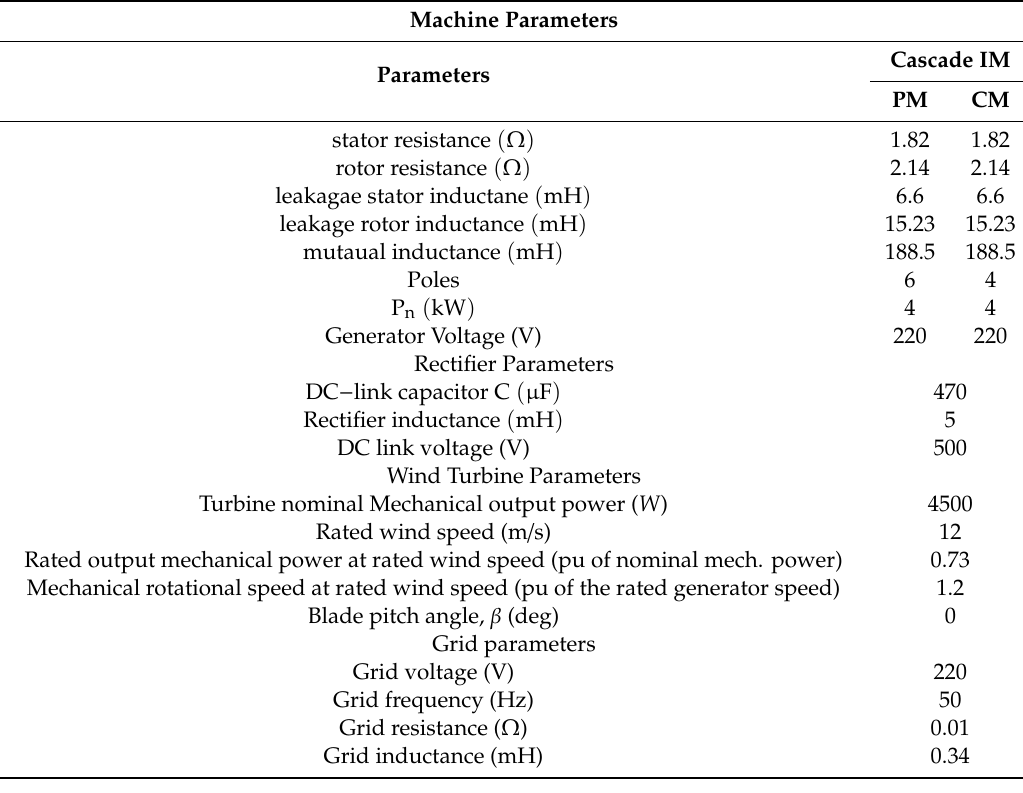
Table 2. Investigated BDFTIG-wind energy conversion systems (WECS)